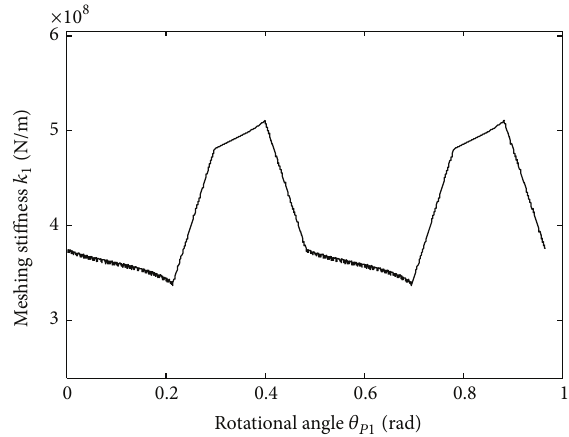
Figure 13: The meshing stiffness of 1st gear pair.